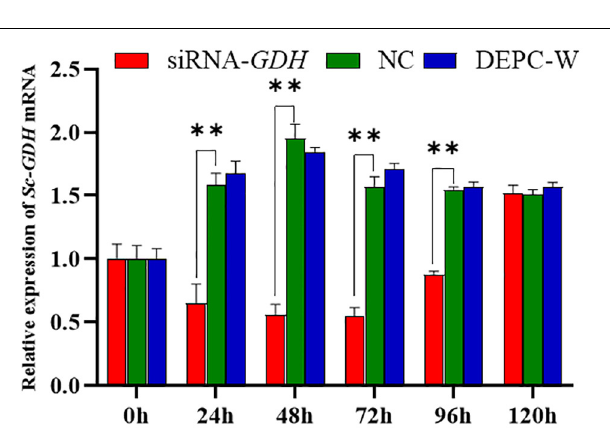
FIGURE 5 | Relative expression of Sc-GDH genes in the hepatopancreas after RNA interference. Vertical bars represented the mean ± SD ( n = 4). ∗∗ Extremely significant difference between siRNA- GDH and NC ( P <